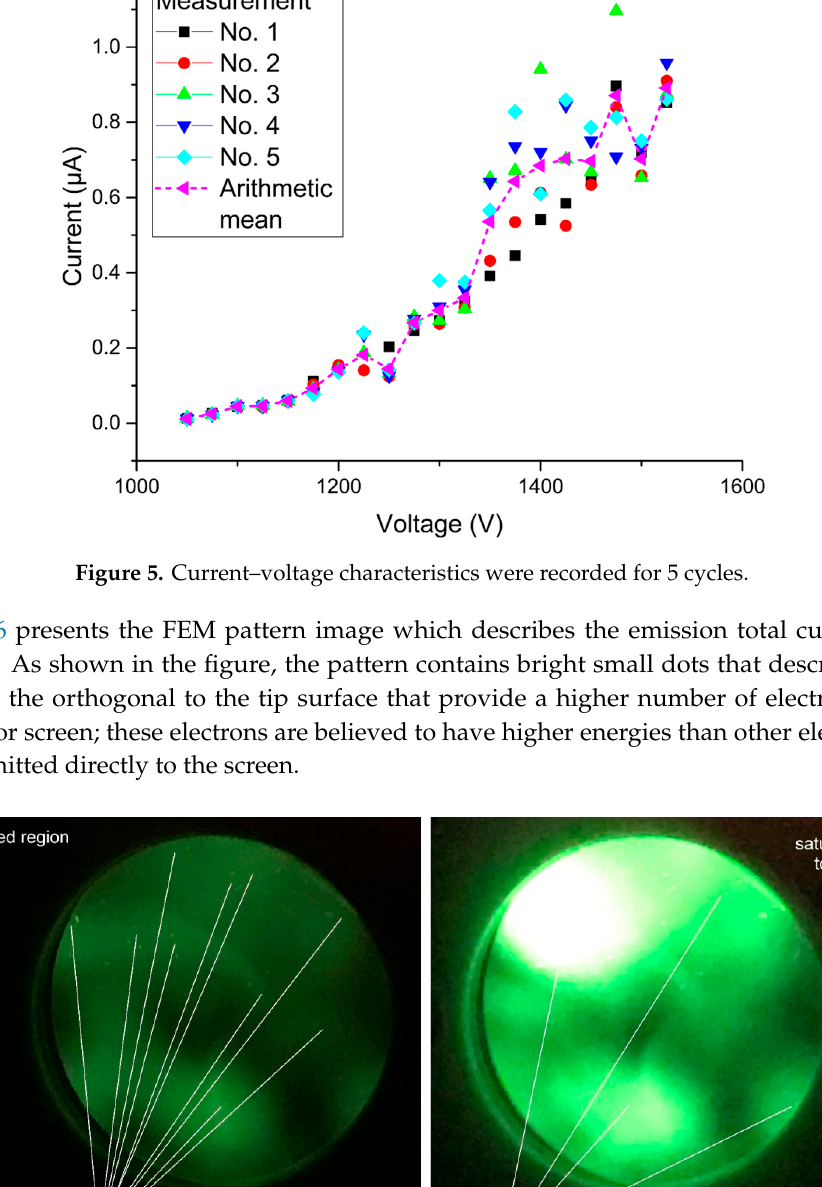
. Table 1. Extracted emitter’s parameters were obtained from the Murphy–Good plots. Measure n.